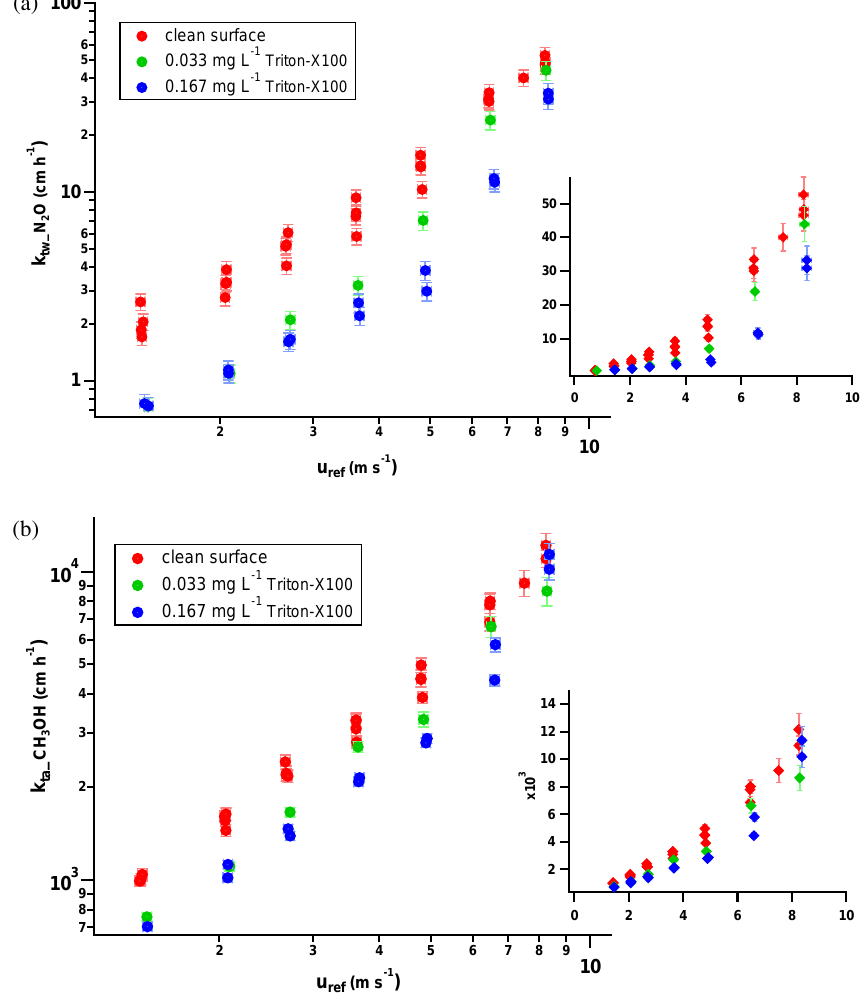
Figure 9. Effect of the two different surfactant concentrations on the total transfer velocities of (a) N 2 O and (b) CH 3 OH. The clean water surface results are given in red, the results obtained using 0.033mgL − 1 Triton X-100 in green and the ones using 0.167mgL − 1 Triton X-100 in